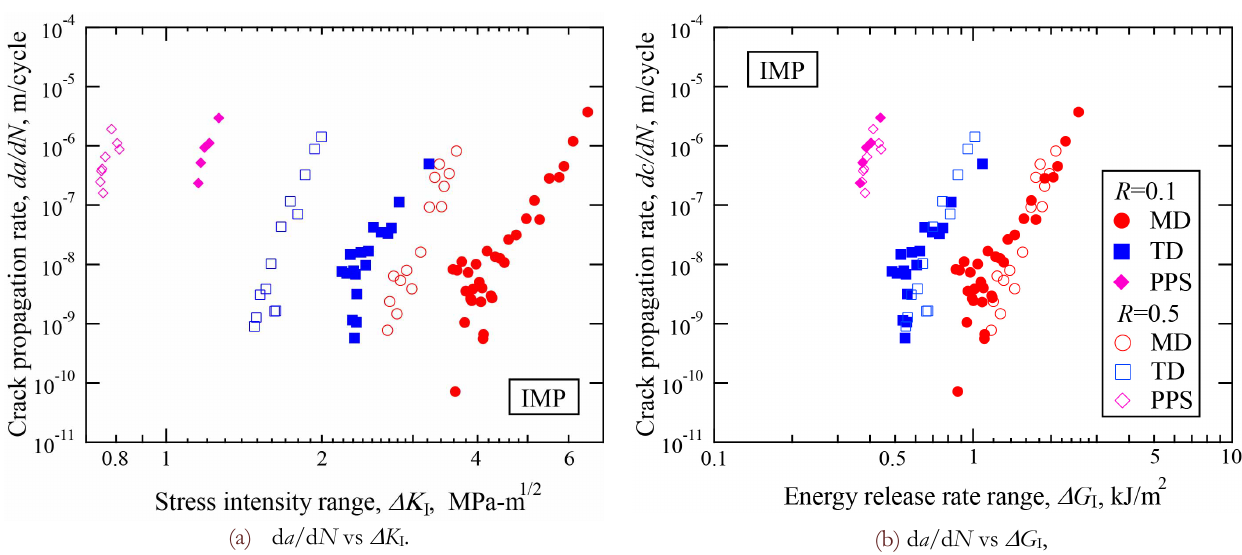
Figure 4: Crack propagation rate correlated to ranges of stress intensity factor and energy release